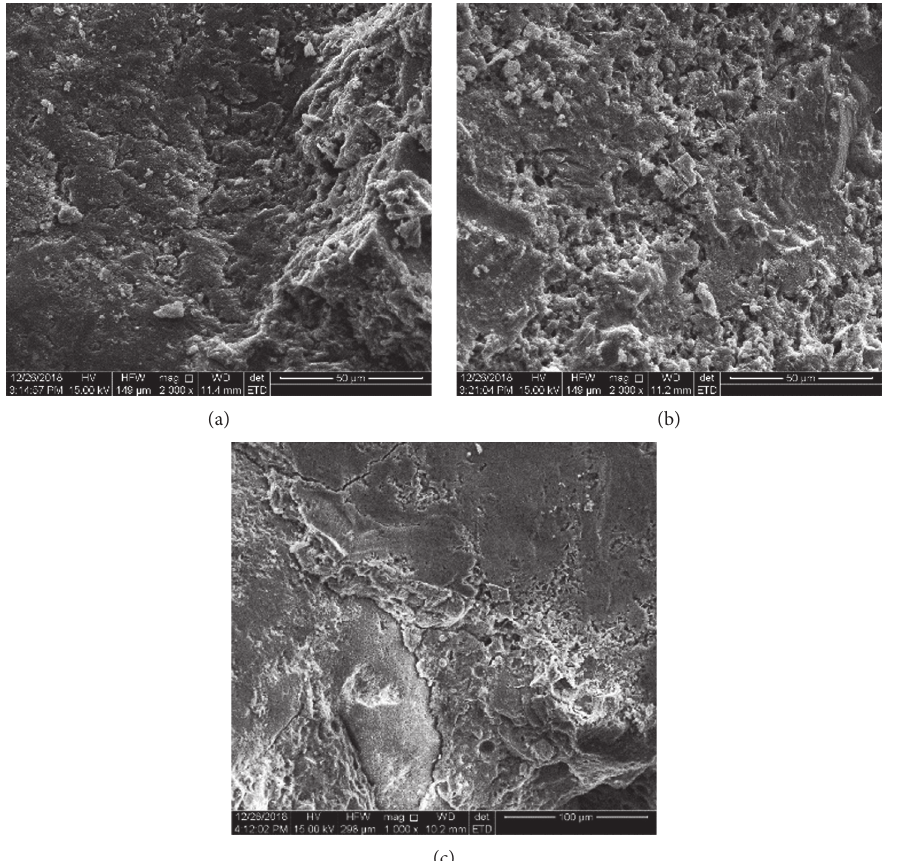
Figure 12: SEM photographs of the concrete under different salt-freezing cycles. (a) D8C8, (b) D16C8, and (c)